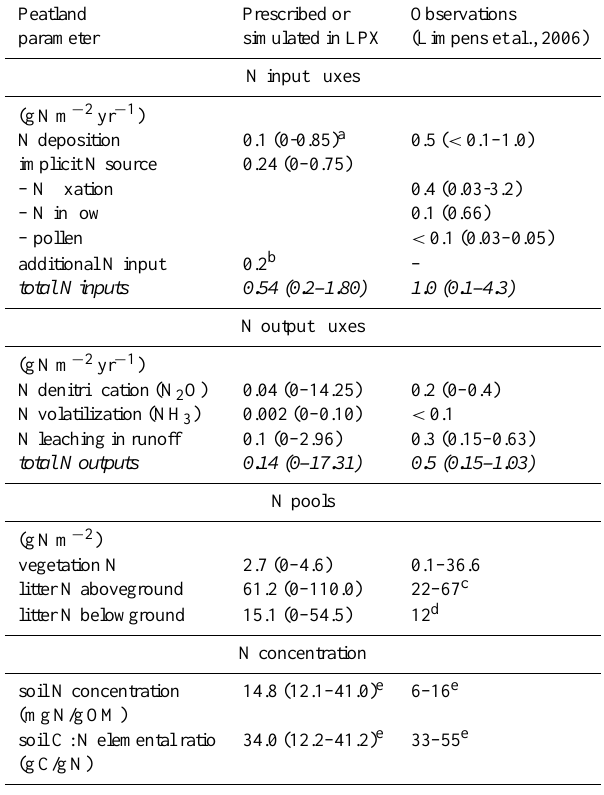
Table 2. Simulated and prescribed peatland N fluxes, N pools and soil C:N ratio in comparison with observations (Limpens et al., 2006). LPX values denote the averages weighted by peatland area and the simulated range of grid cell values in brackets. For calcula- tions, organic matter (OM) contains 50% carbon